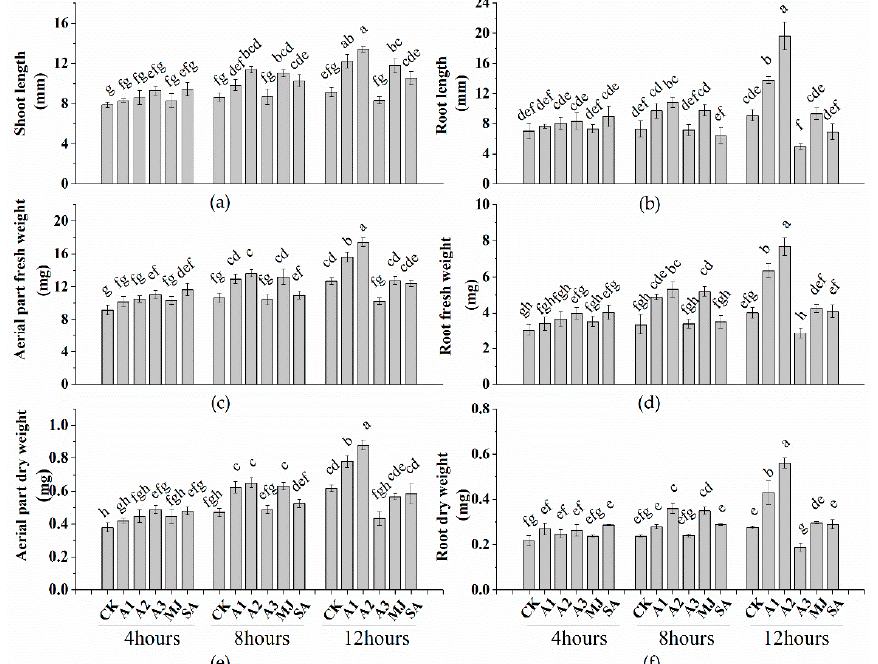
Figure 2. The interaction effects of various priming conditions on the morphological parameters of eggplant. ( a,b ) Shoot and root length, ( c,d ) Fresh weight of aerial part and roots, ( e,f ) Dry weight of aerial part and roots. CK (Distilled water), A1, A2, and A3 (AGE 100, 200, and 300 µg mL − 1 ), MJ (MeJA 0.05 mM) and SA (Salicylic acid 0.5 mM), whereas 4, 8-, and 12-h are priming durations. Bars represent mean and standard errors ( n = 20). Data were subjected to analysis of variance (ANOVA) and LSD ( p = 0.05). Means followed by same letters have no significant difference. Table 1. E ff ect of treatments and priming durations on morphological parameters of eggplant seedlings.